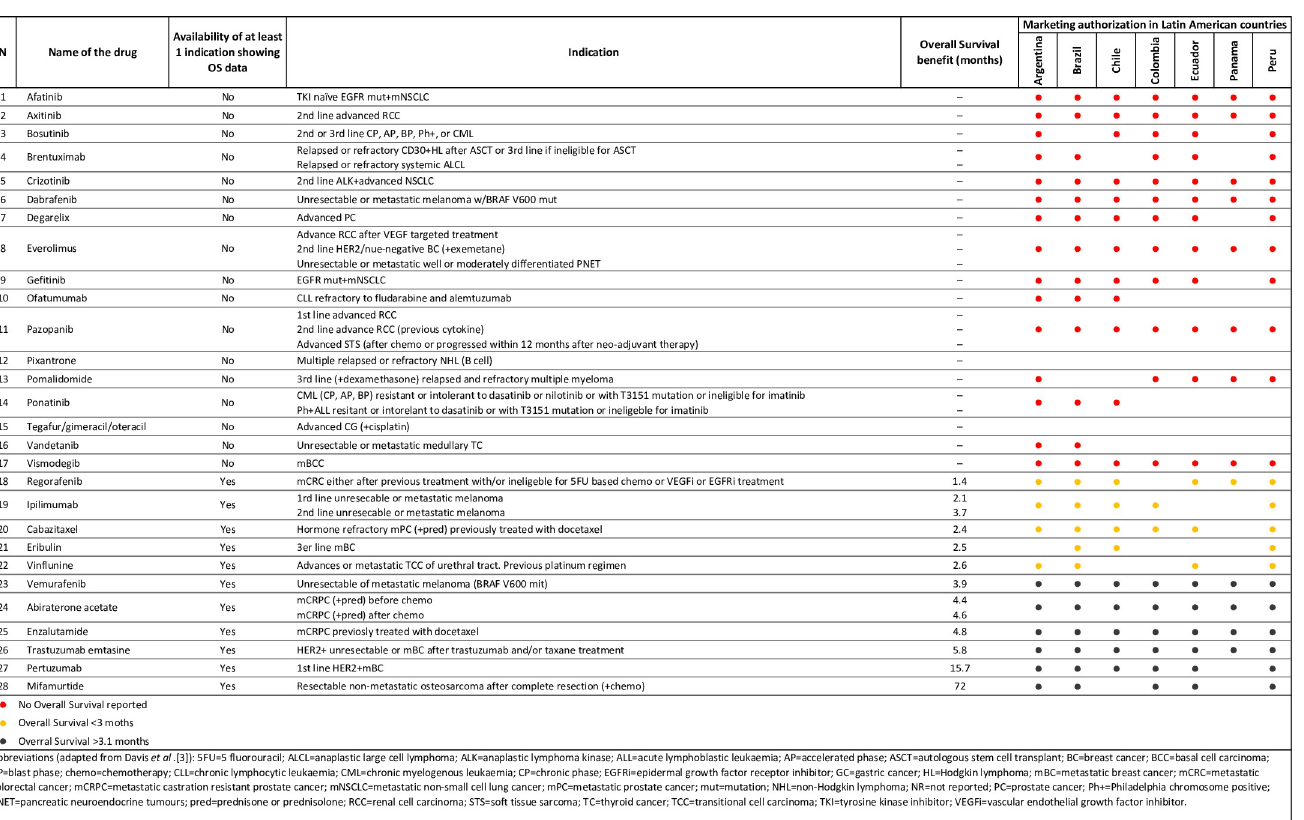
Fig 3. Overall survival benefit of new cancer drugs approved by 7 Latin American countries (2009–2013).